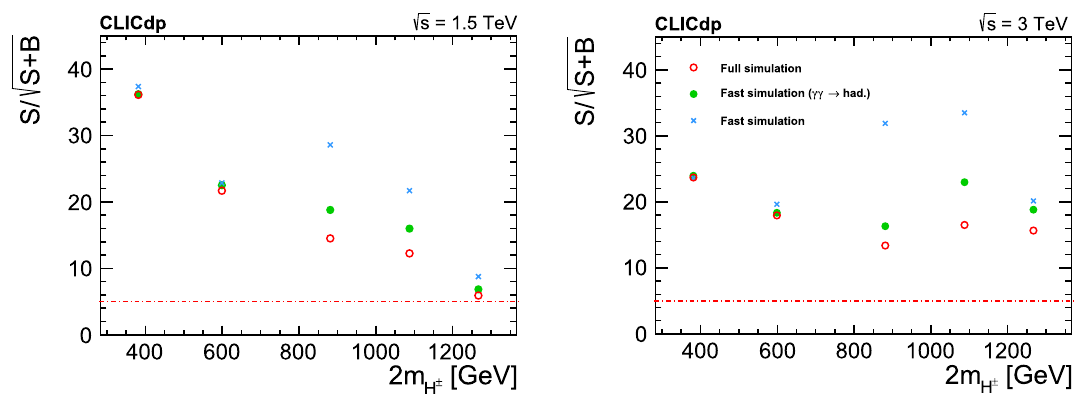
Fig. 5 Statistical significance expected from the full simulation study (red points), compared with the fast simulation results after including the overlay background (green points). The significance obtainable from the fast simulation analysis without the influence of the overlay are shown for comparison as blue crosses. The results are presented for considered benchmark points as a function of 2 m H CLIC running, and were produced with the selection optimised for a particular scenario. The red line shows the 5 σ